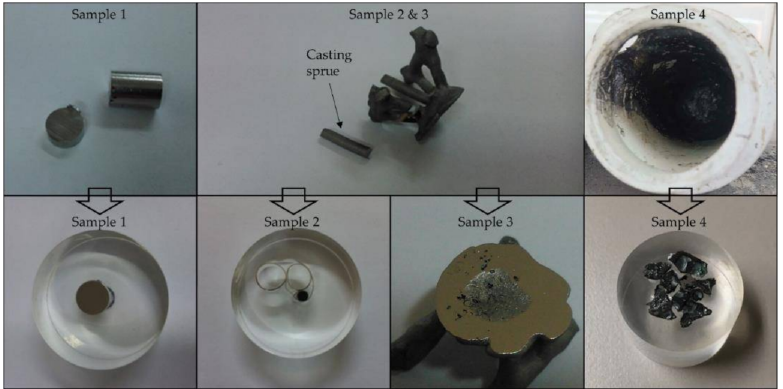
Figure 1. Presentation of samples of CoCr alloy (samples 1–4), mounted and prepared